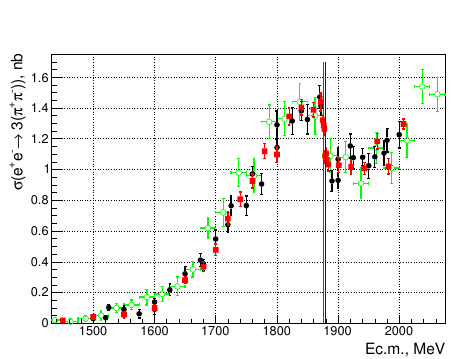
Figure 7. Fit of the e + e − → 3( π + π − ) cross section near the NN threshold (CMD-3, 2017 data). The curves are described in the text. The vertical lines show the pp and nn production